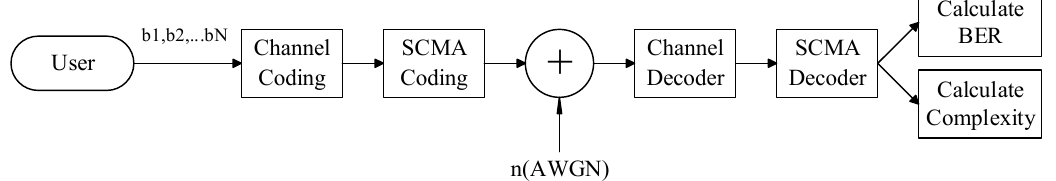
Figure 1. Uplink Sparse Code Multiple Access (SCMA) system block diagram.